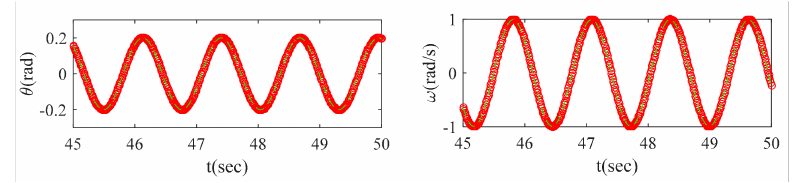
Figure 17. A comparison of the results using Lie algebra and standard